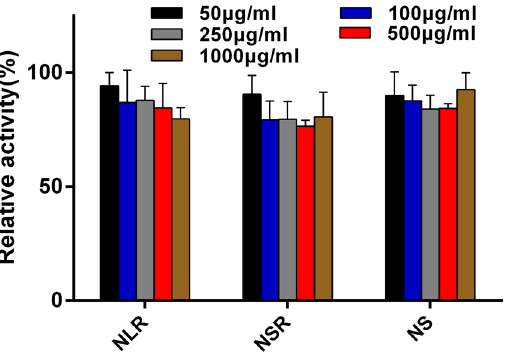
Figure 3. Effect of three types of MSNs on the Caco-2 cell viability at various concentrations from 50 μ g/mL to 1000 μ g/mL.